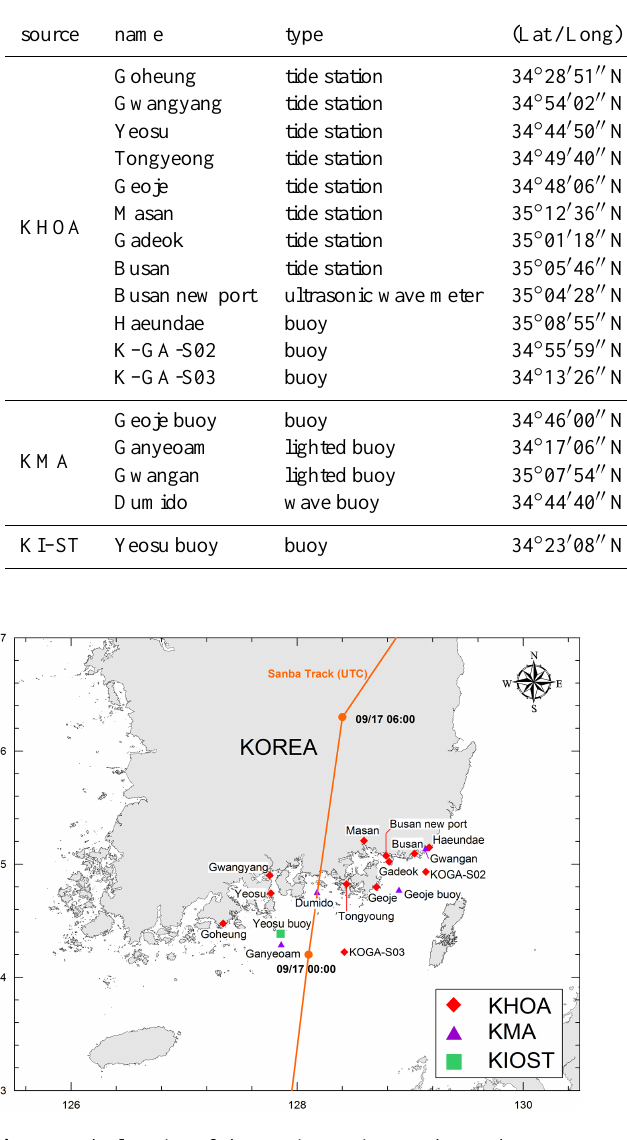
Figure 4. The location of observation stations on the southern coast of